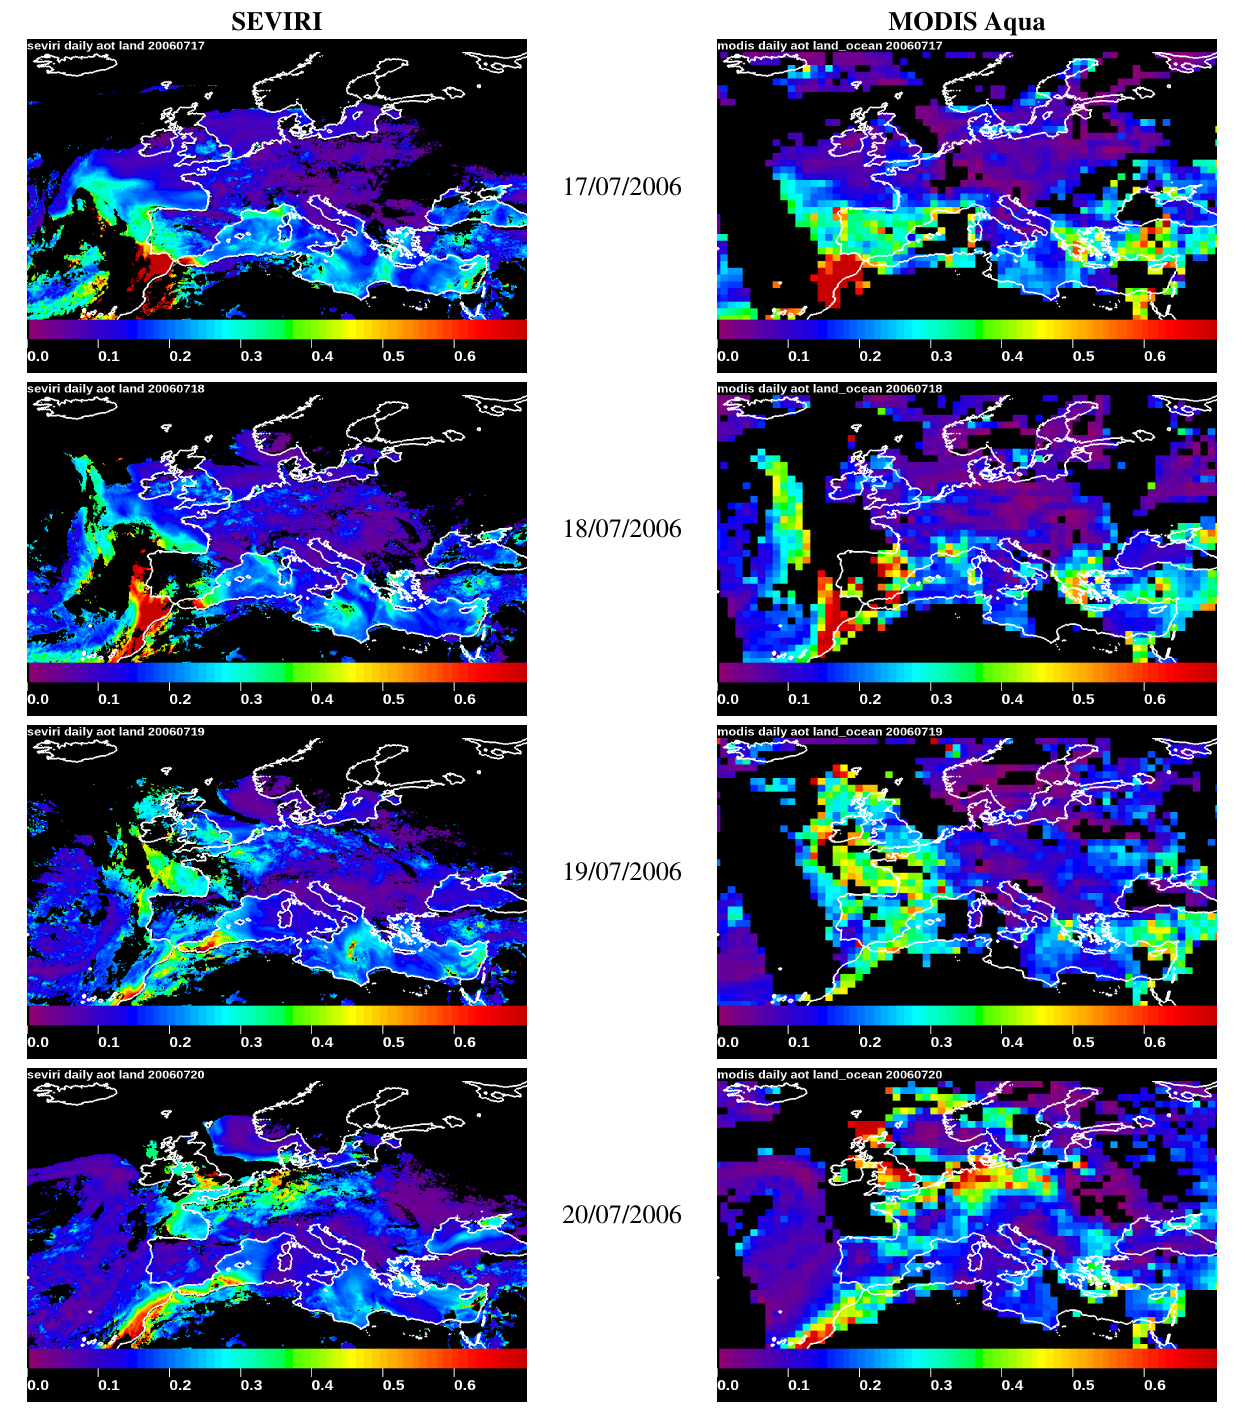
Fig. 12. Daily AOT maps at 0.6µm above Europe for SEVIRI (left panel) and MODIS (right panel) sensors. The spatial resolution of SEVIRI is 0.1 ◦ × 0.1 ◦ while it is 1 ◦ for MODIS. Days presented are from the 17 (top panel) to the 20 (bottom panel) July 2006. The color scale is from 0 to 0.7.